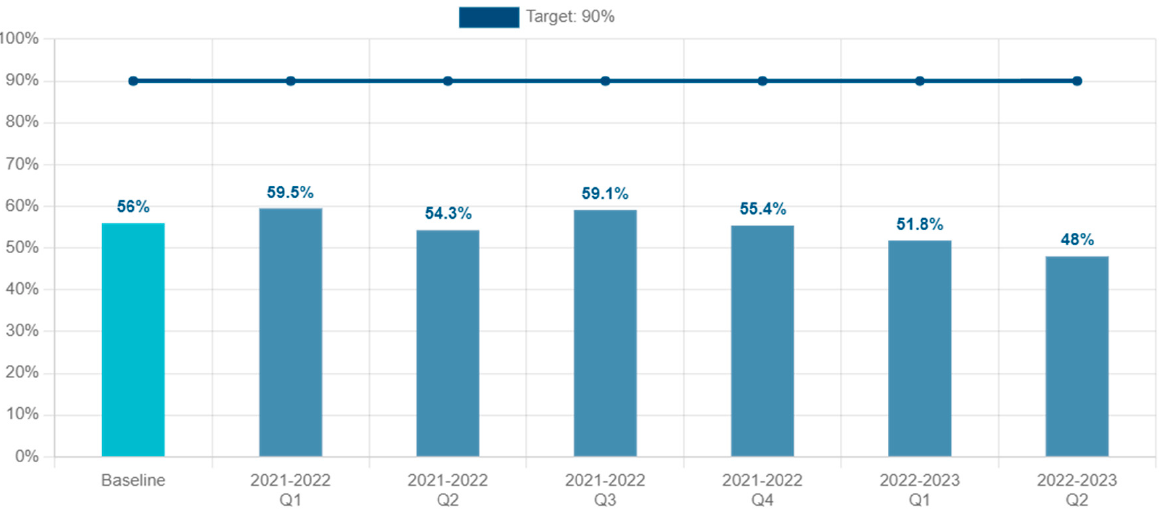
Table 3. Results of executing SA and hybrid SA algorithms in the first quarter (10 ORs) .